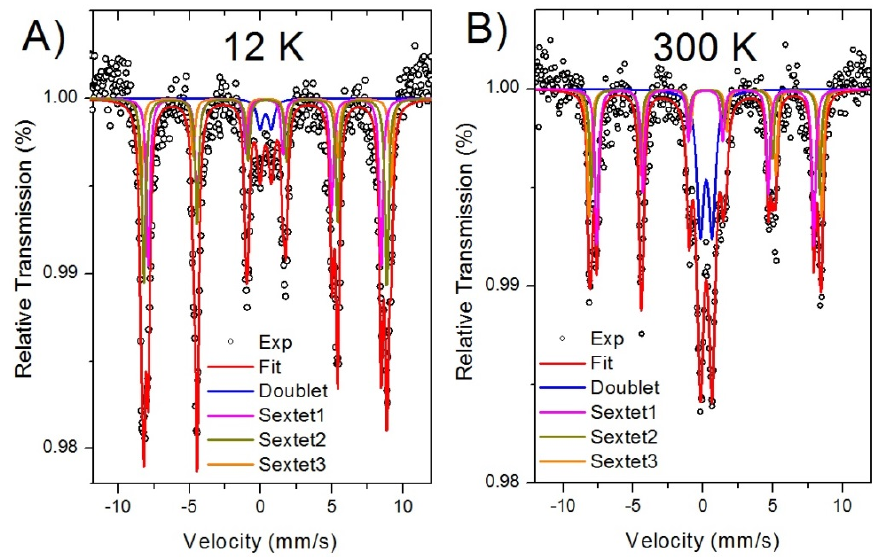
Figure 3. Mössbauer spectroscopy of the CoFe 2 O 4 /Fe 2 O 3 -KIT-6 catalyst: ( A ) at 12 K; ( B ) at 300 K.